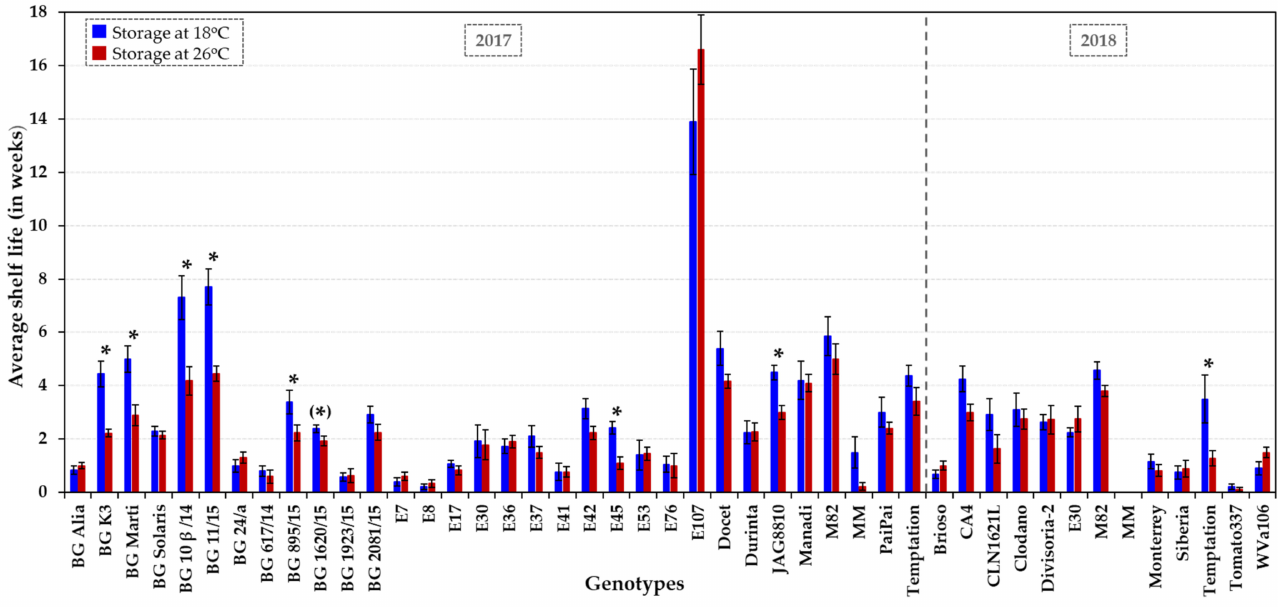
Figure 1. Shelf life of tomato accessions showing thermotolerance or sensitivity under field and glasshouse conditions. Shelf life was assessed at two temperature regimes, at low (18 ◦ C, dark blue columns) and elevated (26 ◦ C, dark red columns) ambient temperature over two growing seasons (2017 and 2018). On average, 10–11 fruits were used per genotype– temperature–year combination (about 1000 tomatoes in total) to determine the average shelf life (in weeks). The error bars represent ± the standard error (SE). An asterisk indicates a significant difference ( p < 0.05 or p ~ 0.05 when in parenthesis) in shelf life at 18 ◦ C vs. 26 ◦ C for each genotype. Statistical analyses are presented in Figure S2, including the comparison between genotypes at each temperature. HS accessions (BG Solaris, BG 24/a, CA4, Clodano, E30 and E41) and control genotypes (JAG8810, Docet, MM and M82) are included for comparative